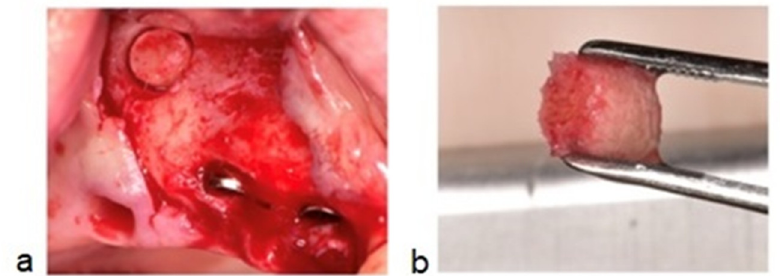
Figure 5. Histomorphometric evaluation of new bone amount by point counting method in case no. 4.